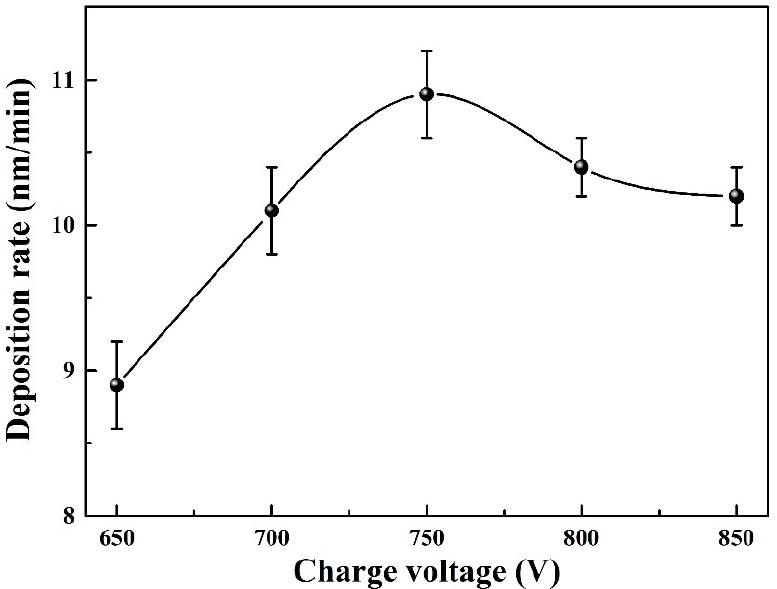
Figure 2. Deposition rate of Mo–Cu–V–N coatings as a function of charge voltage.